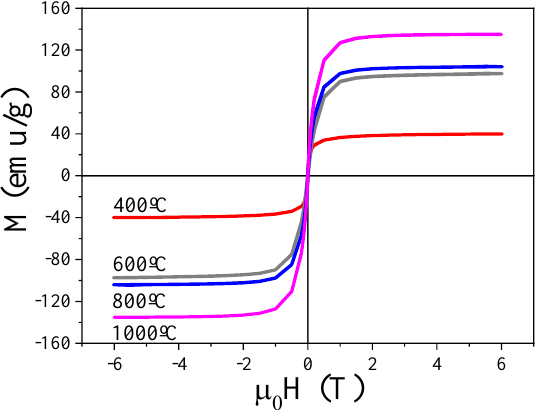
Figure 6. Magnetic hysteresis loops at 300 K of the annealed samples.